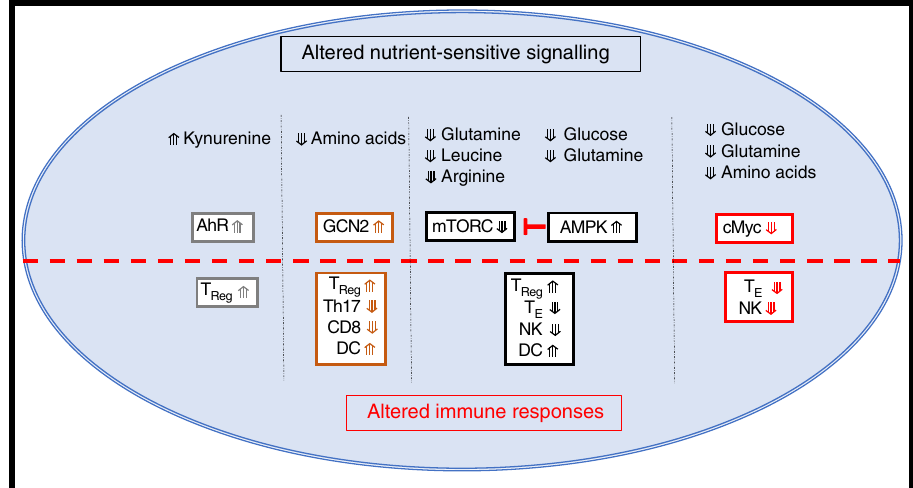
Fig. 5 Immunological consequences of changes in nutrient signalling. Activation of AMP-activated protein kinase (AMPK) or inhibition of mammalian Target of Rapamycin Complex 1 (mTORC1) signalling promotes the differentiation of regulatory T (T Reg ) cells over effector T cell subsets (T E ), inhibits natural killer (NK) cell functions, and increases the proin fl ammatory outputs of dendritic cells (DC). Loss of cMyc expression inhibits the functions of T E subsets and NK cells. Activation of general control nonderepressible 2 (GCN2) signalling promotes T Reg differentiation, inhibits Th17 differentiation, inhibits CD8 T cell function, and enhances the function of DC. Kynurenine (Kyn)-mediated aryl hydrocarbon receptor (AhR) signalling promotes the differentiation of T